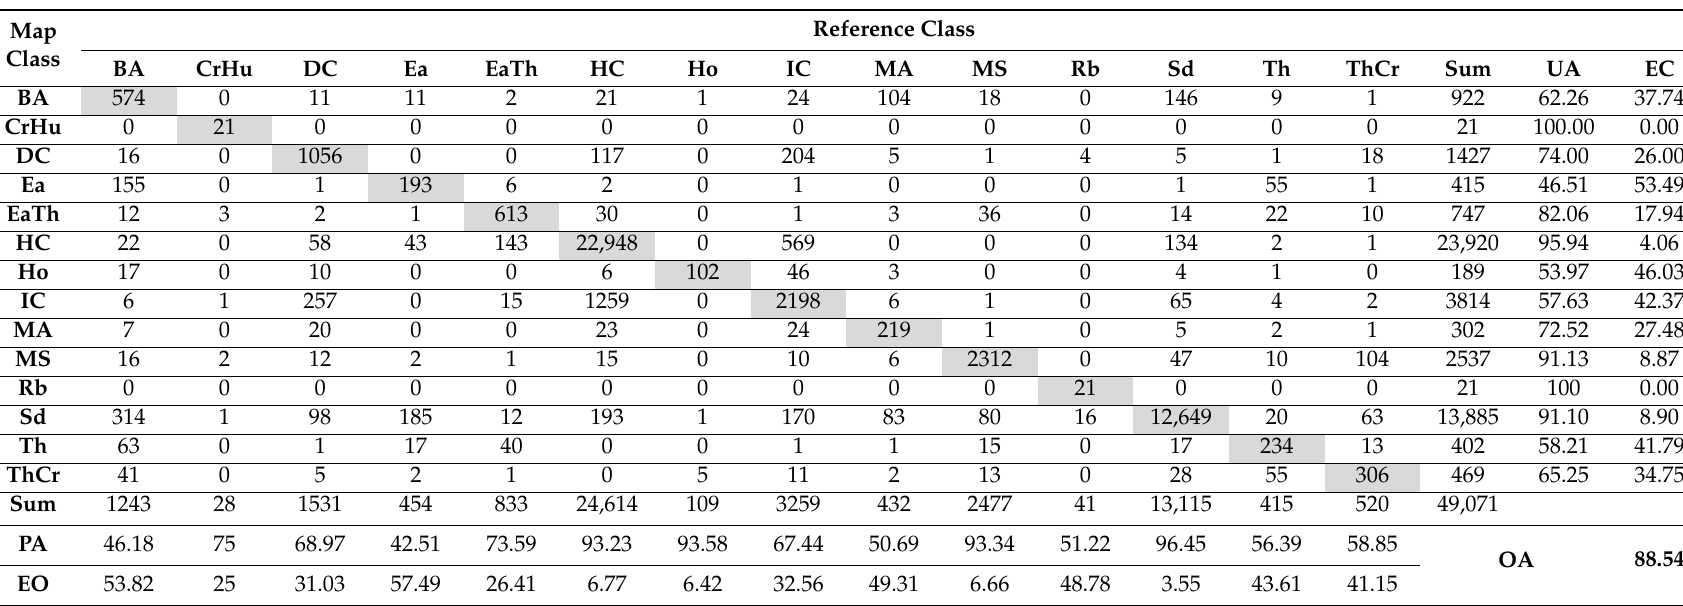
Table 4. Confusion matrix of RF result. HC: Healthy Coral, IC: Intermediate Coral, DC: Dead Coral, BA: Brown Algae, MA: Mixed-Algae, MS: Mixed-Seagrass, Rb: Rubble, Sd: Sand. OA: Overall Accuracy, UA: User Accuracy, PA: Producer Accuracy, EC: Error Commission, EO: Error